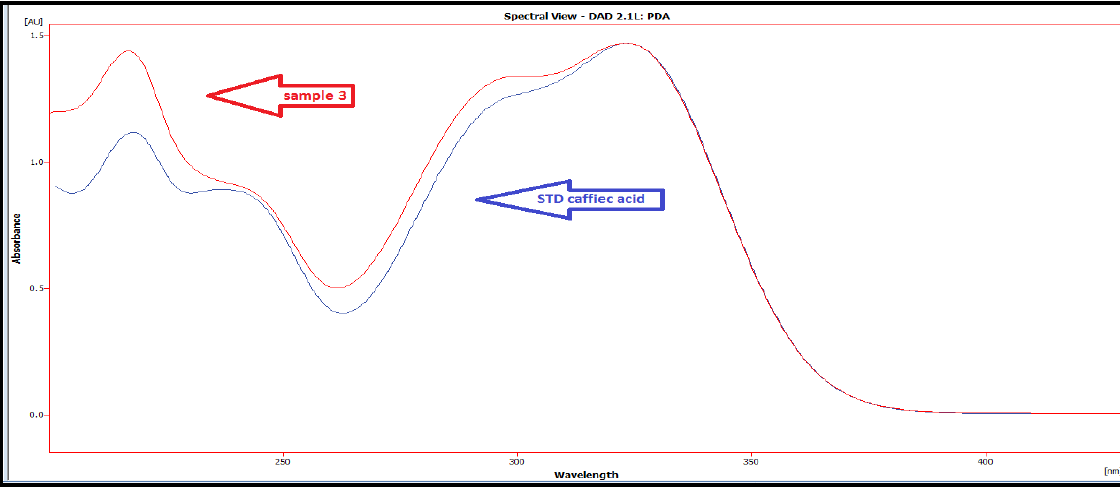
Figure 19. UV spectrum of isolated compound number 3 and caffeic acid standard. Table 6.Retention times in minutes for standards (rosmarinic acide,sinapic acide ,caffeic acid)and isolated cpd